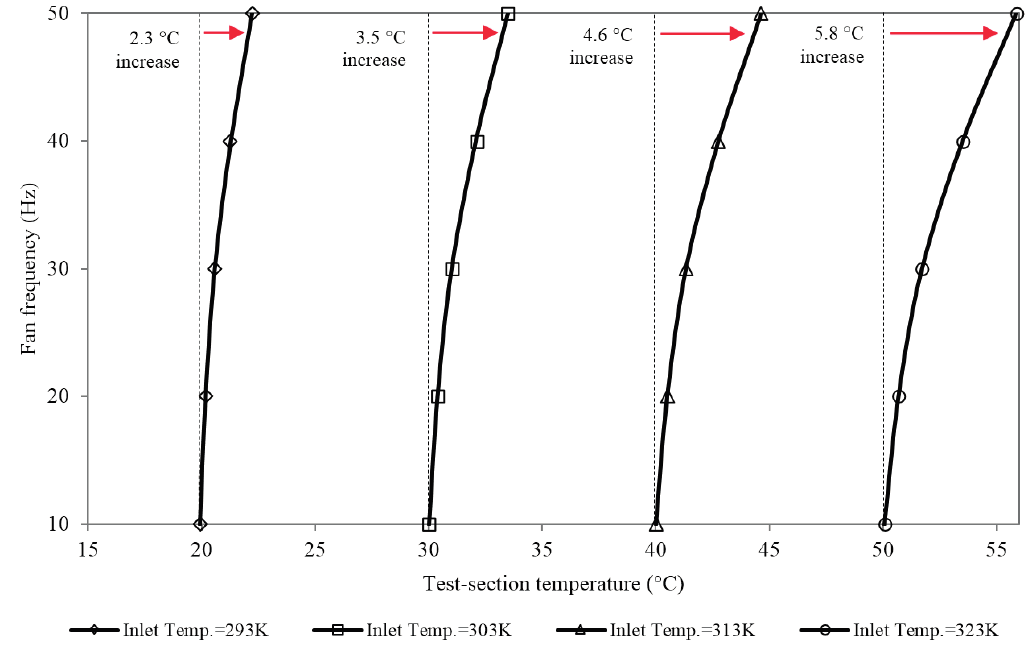
Figure 12. Test-section mean operating temperature at increasing fan frequencies incremented every 300